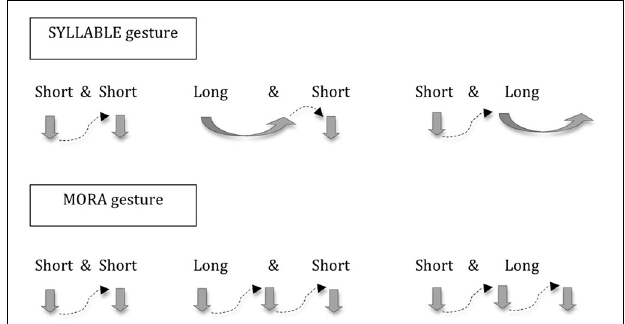
FIGURE 1 | Two types of hand gestures used in the present